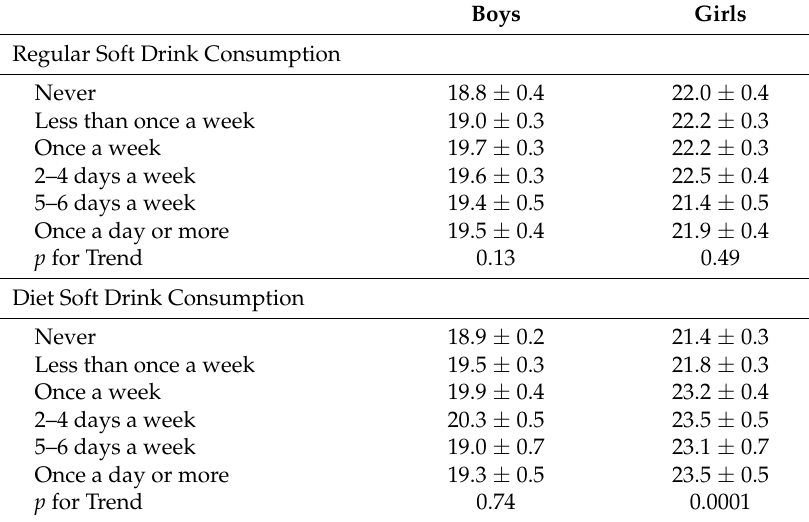
Table 2. Results of multi-level mixed models * testing differences in % body fat (mean ± S.E.) across levels of soft drink consumption in the International Study of Childhood Obesity, Lifestyle and the Environment